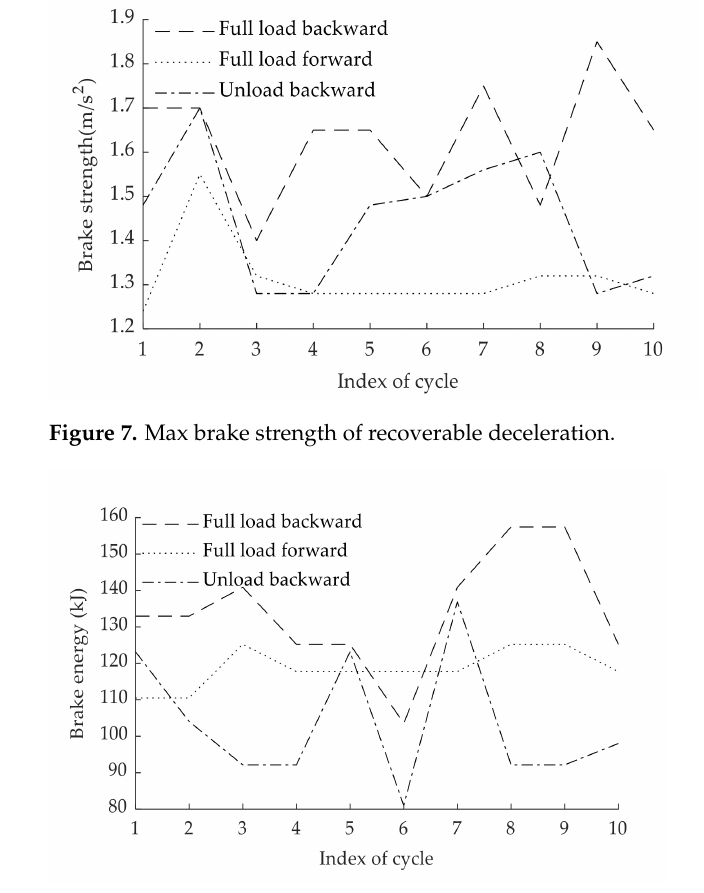
Figure 8. Max brake energy of recoverable deceleration.